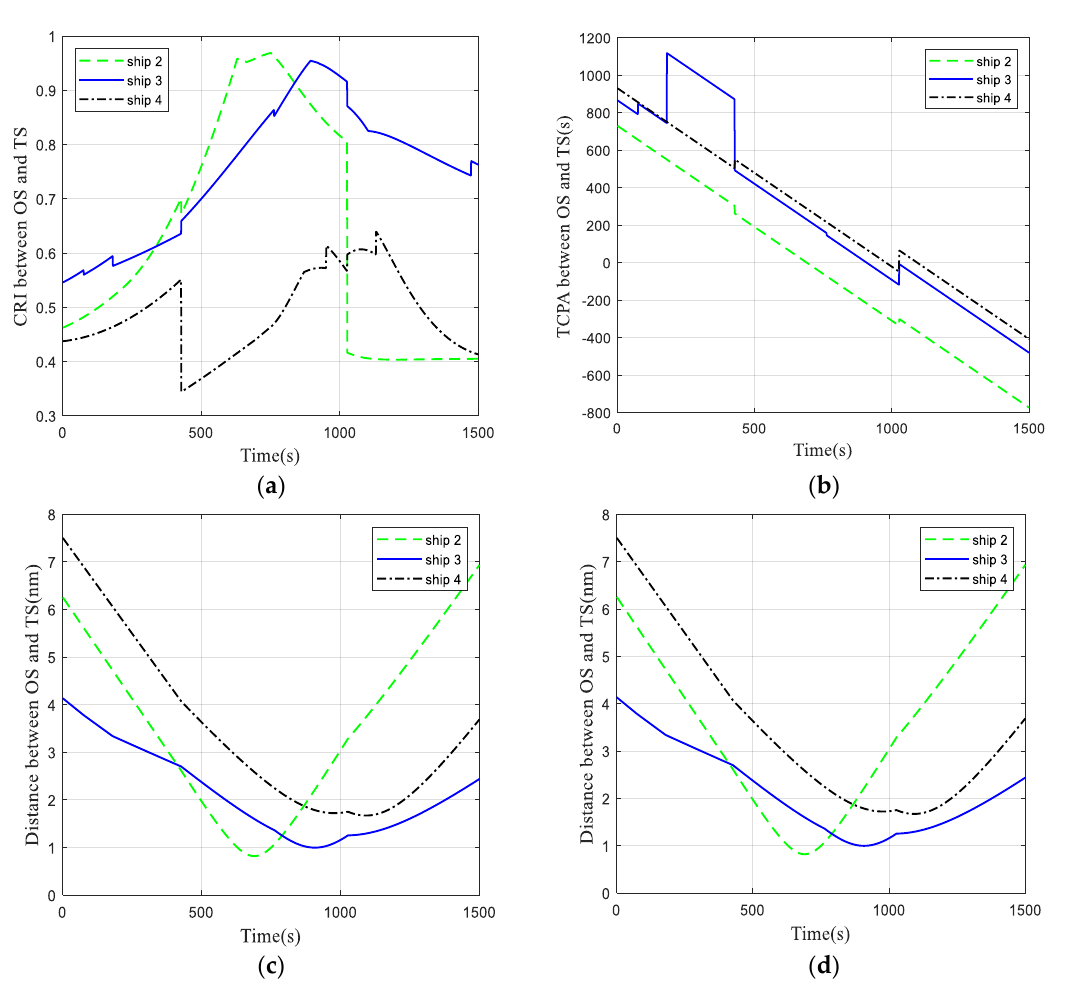
Figure 8. Real-time parameter changes under scenario 2: ( a ) the collision risk index ( CRI ) with the Target Ships (TSs), ( b ) the time to the closest point of approach ( TCPA ) with the TSs, ( c ) the relative distance with the TSs and ( d ) the distance to the closest point of approach ( DCPA ) with the TSs. Table 3. Actions taken by each ship under scenario 2.